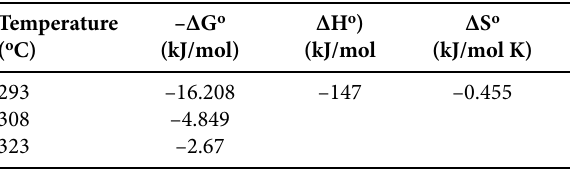
Table 5. Thermodynamic parameters for the sorption process of so- dium ion from aqueous solution using activated carbon